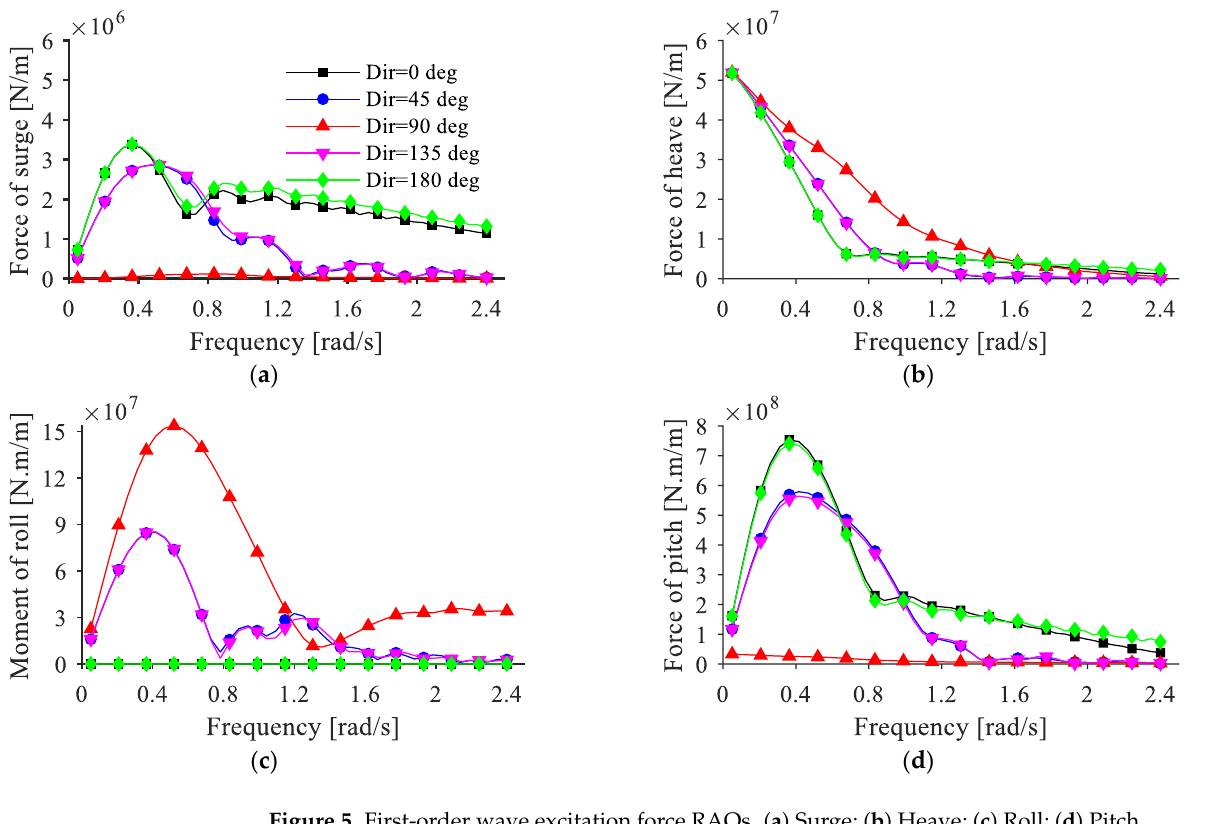
Figure 5. First-order wave excitation force RAOs. ( a ) Surge; ( b ) Heave; ( c ) Roll; ( d ) Pitch.